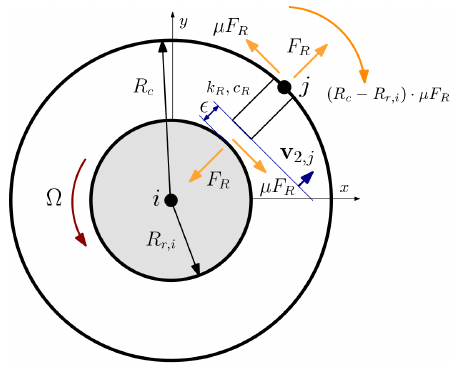
Figure 7. Rub model and forces at shaft and casing